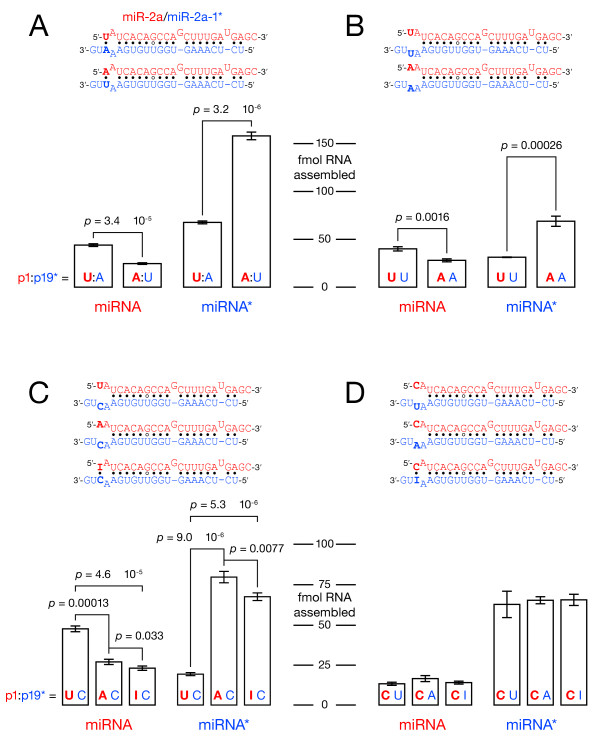
Identity of the first miRNA nucleotide affects duplex asymmetry. RNA-induced silencing complex (RISC) loading of miRNA and miRNA* strands was measured after in vitro assembly. Data are reported as means ± standard deviation for three independent replicate experiments. (A) Swapping the terminal uridine:adenosine (U:A) pair of the miR-2a/miR-2a-1* duplex decreased miRNA loading and increased miRNA* loading. (B) The effect of the terminal A:U pair mainly reflects the identity of the first miRNA nucleotide, which affects both miRNA and miRNA* loading (C), whereas the identity of the facing miRNA* nucleotide has no detectable effect (D).